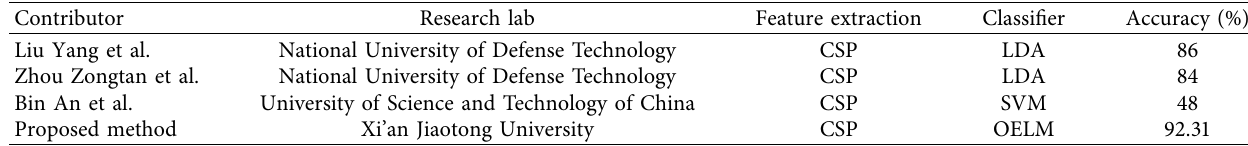
Table 7: Classification results comparing the proposed method with other